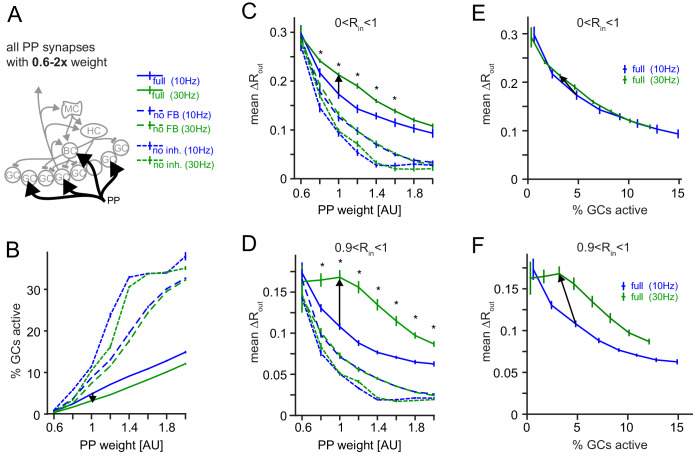
Robustness for increased perforant path (PP) drive.The weight of the PP input synapses was varied between 0.6x to 2x their original weight. (A) Illustration of the network alteration. (B) Active GC fractions for the full network (full), the no feedback inhibition network (no FB) and the no inhibition network (no inh.), each for 10 and 30 Hz modulated PP input. The black arrow indicates the frequency effect for the default PP-weight (1x). (C) Full pattern separation effects over all input similarities (0 < Rin < 1). Asterisks indicate p<0.05 (uncorrected t-tests). (D) Full pattern separation effects for highly similar input patterns (0 < Rin < 1). Asterisks indicate p<0.05 (uncorrected t-tests). (E) Data for the full network from (B) and (C) plotted to show pattern separation as a function of GC sparsity. The arrow represents the default PP input strength. (F) Same as E, but only for highly similar input patterns.